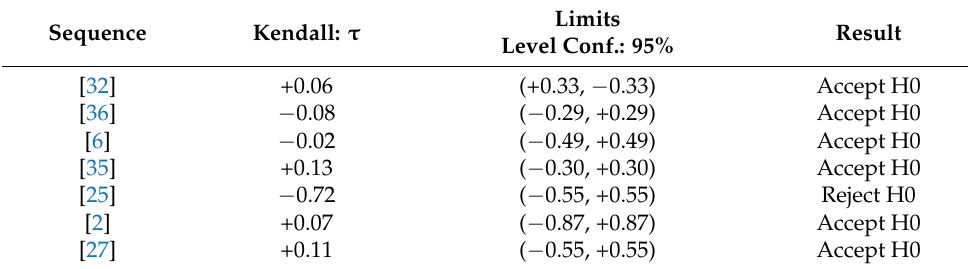
Table 5. Kendall contrast: